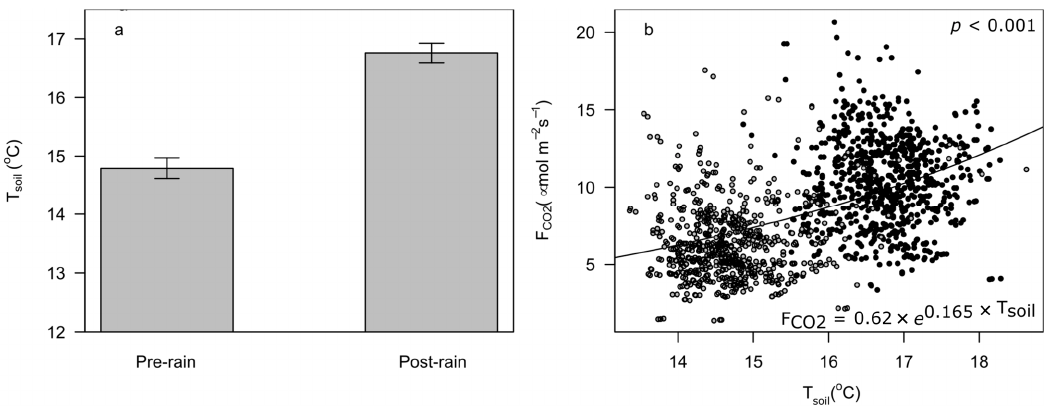
Figure 4. Soil temperature patterns and effects on soil CO 2 efflux. Soil temperatures (T soil ) before and after wetting were significantly different (( a ), p < 0.001, error bars indicate 95% confidence intervals). Observed fluxes were sensitive to soil temperatures ( b ). The exponential rate of increase was estimated to be Q 10 = 5.81 (± 0.45 s.e.). Open dots indicate pre-rain soil fluxes observations and filled dots indicate post-rain fluxes.